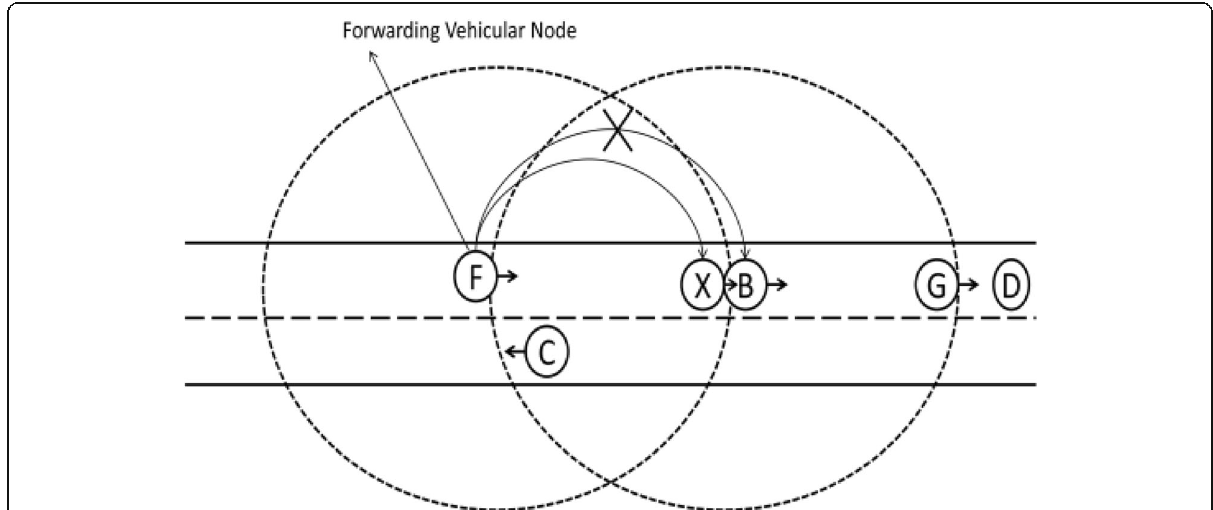
Fig. 4 Limitation of existing forwarding strategies without link stability. F is the forwarding node, X and B are the neighbors that are moving in the direction of destination, and C is a vehicle traveling in opposite direction to the destination. D is the destination node. The big dotted circles represent the transmission ranges of the